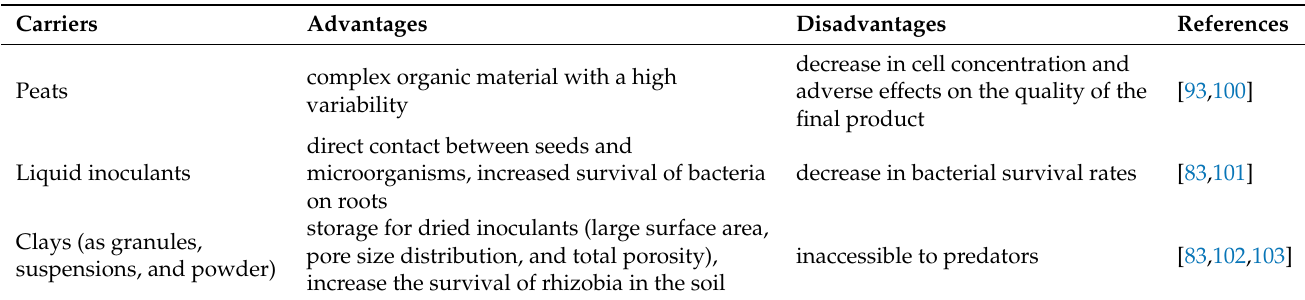
Table 2. Traditional carriers for microbial rhizobacteria